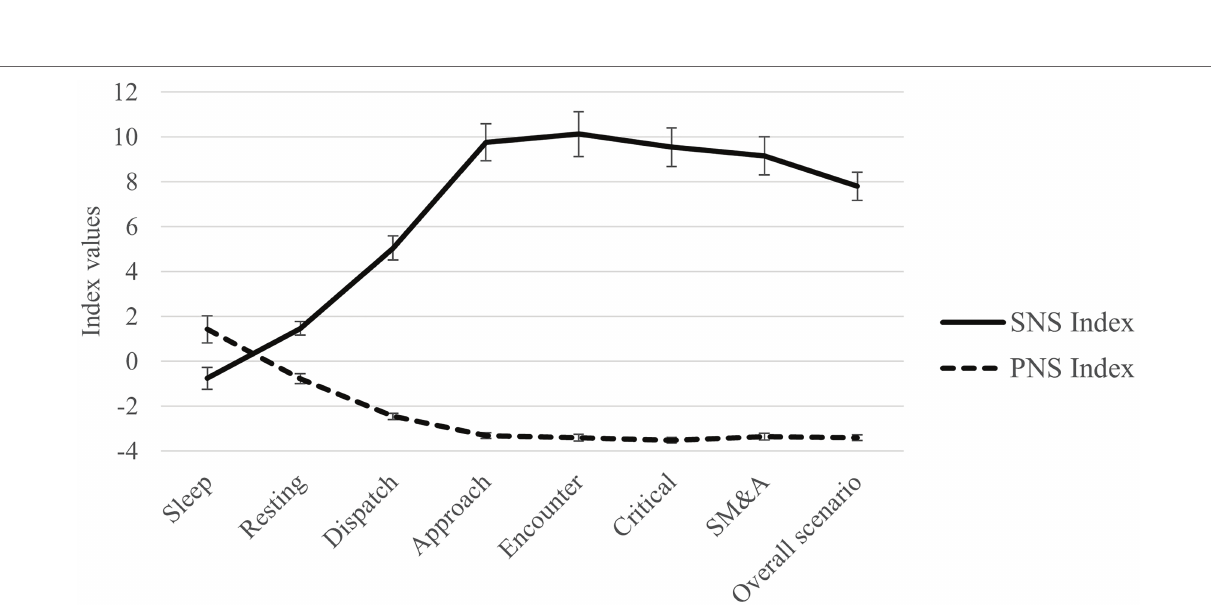
FIGURE 2 | Sympathetic nervous system (SNS) and parasympathetic nervous system (PNS) index values during sleep, while at rest, and during the phases of the scenario. SM&A, scene management and aftercare. 95% CI error bars